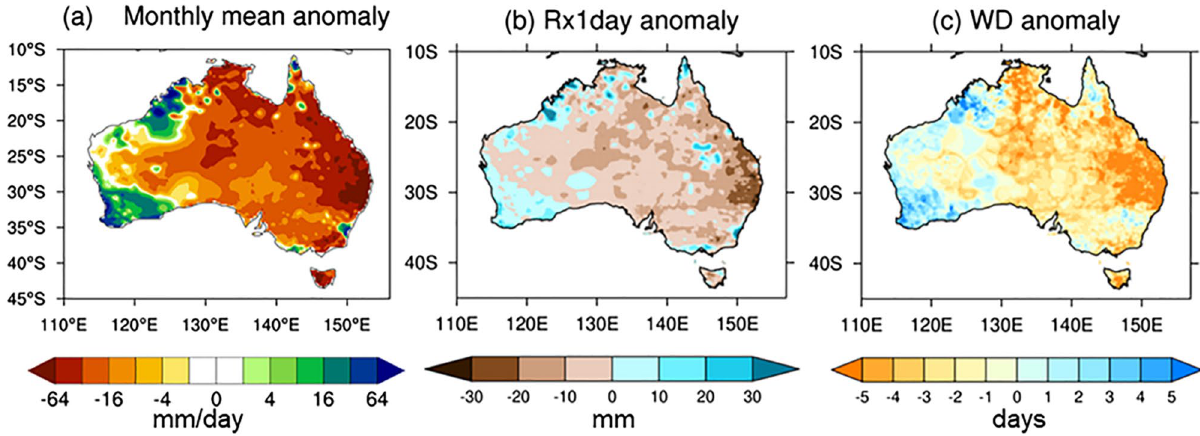
Figure 7. November 2020 rainfall anomalies. ( a ) Monthly mean, ( b ) 1-day maximum rainfall amount of the month (Rx1day; i.e., the intensity of the wettest day in the month), and ( c ) number of wet days (> 1 mm; WD). Maps were generated using the NCAR Command Language version 6.6.2 (www. ncl. ucar. edu) ( a ) and the IDL version 8.6 (https:// idlsg roup. com/) ( b , c ).